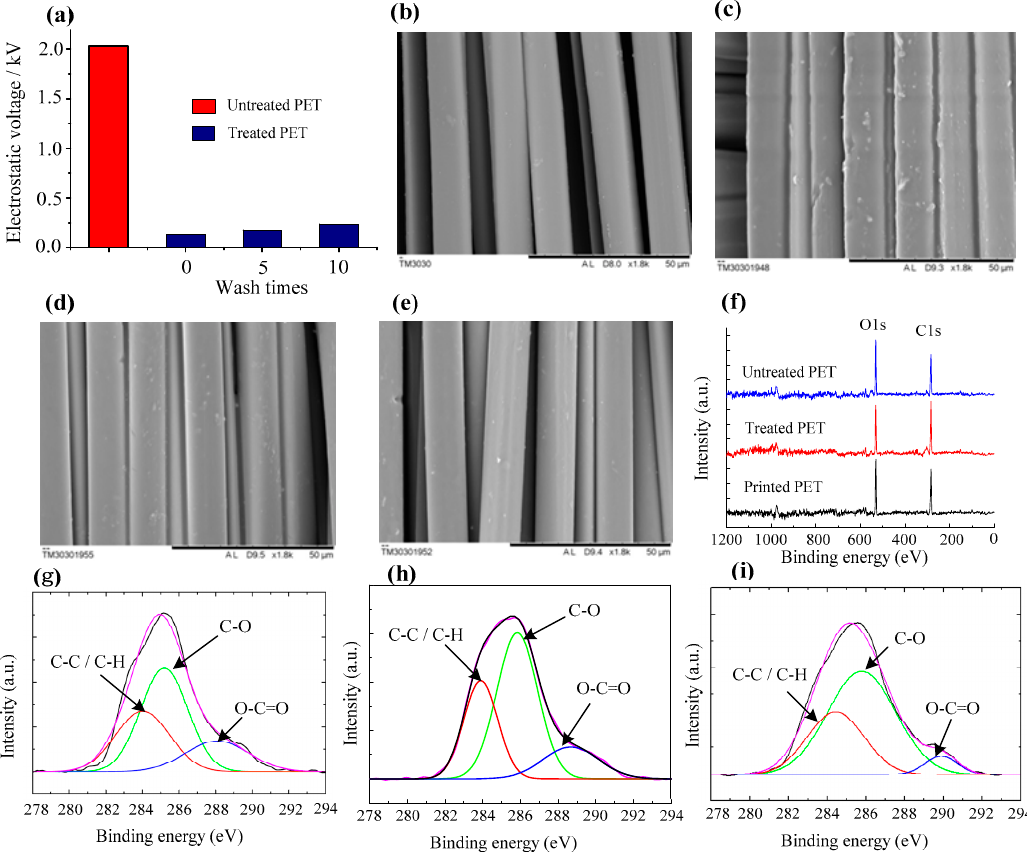
Figure 6. Wash stability and durability of treated PET fabric. ( a ) Change of electrostatic voltage of P[St-BA-F6]-treated fabric with wash times. ( b ) Scanning electron microscopy (SEM) image of untreated (×1800). ( c ) SEM image of P[St-BA-F6]-treated fabric (×1800), wash times = 0. ( d ) SEM image of P[St-BA-F6]-treated fabric (×1800), wash times = 5. ( e ) SEM image of P[St-BA-F6]-treated fabric (×1800), wash times = 10. ( f ) Wide-scan X-ray photoelectron spectroscopy (XPS) spectra of untreated fabric, P[St-BA-F6]-treated fabric, and printed fabric. ( g ) High-resolution C1s XPS spectrum of untreated fabric. ( h ) High-resolution C1s XPS spectrum of P[St-BA-F6]-treated fabric. ( i ) High-resolution C1s XPS spectrum of printed fabric. All the scale bar on SEM images are 50 μ m.